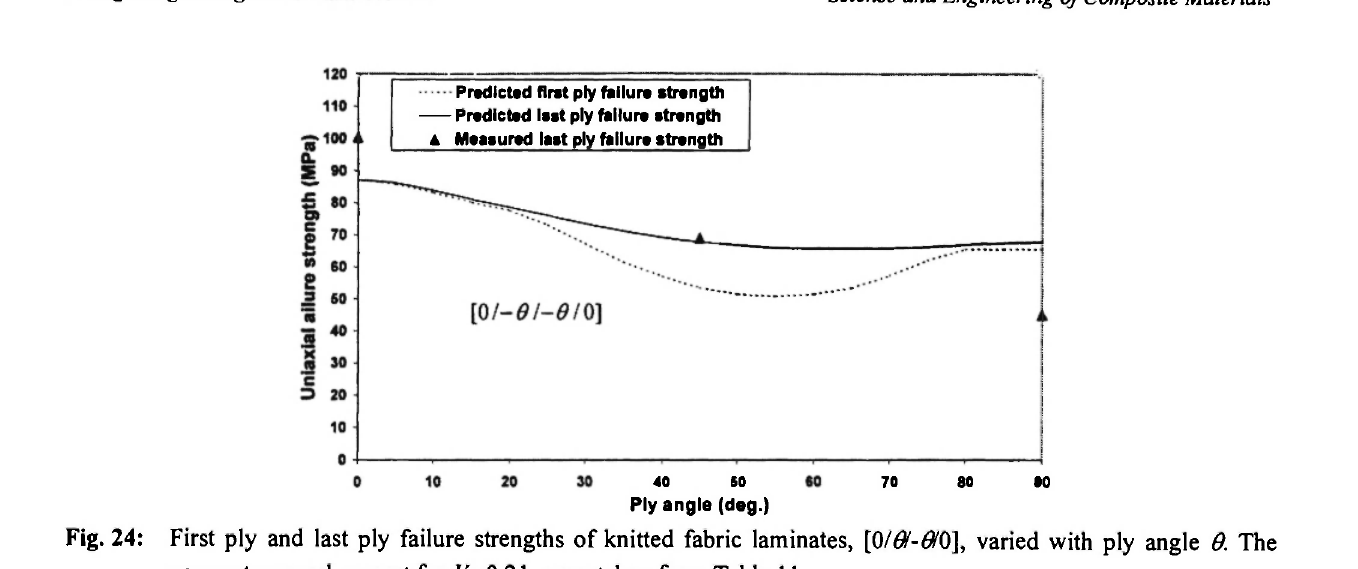
Fig. 24: First ply and last ply failure strengths of knitted fabric laminates, [Q/Θ-ΘΟ], varied with ply angle Θ. The parameters used, except for Vj= 0.21, were taken from Table 11.